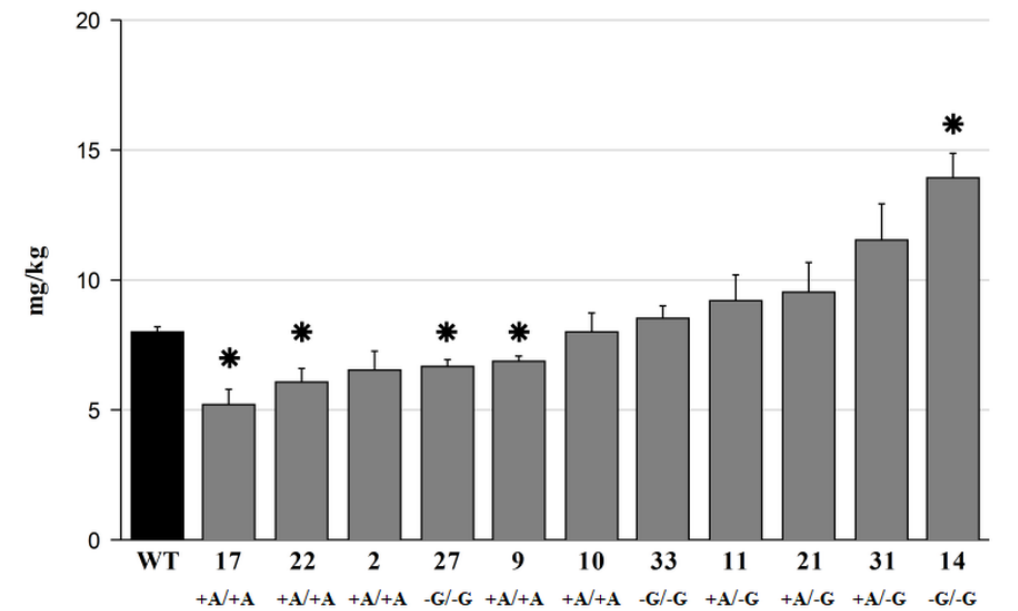
Figure 3. Mature grain phosphate content in itpk1 mutants. Black column – wild-type plant, grey columns–T2 generation itpk1 mutant lines. Allelic constitution at the target site for each of the selected parental T1 3B mutant lines shown below. Data represent means (n = 3 ± SD). The asterisks represent significant differences in the phosphate content at p < 0.05 compared to WT based on the Aspin-Welsch unequal-variance t-test.